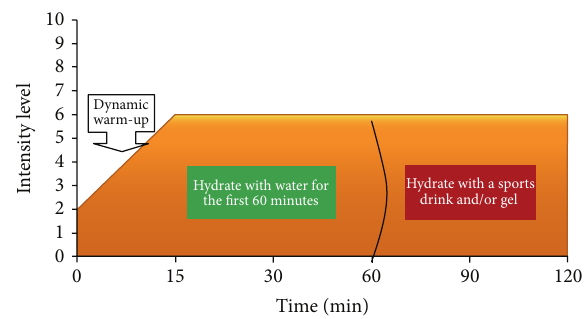
Figure 2: Endurance exercise (E). Perform endurance (E) exercise at an intensity level of 6 for 60 minutes or longer using any form of exercise (walking, jogging, running, cycling, swimming, hiking, cross-country skiing, snowshoeing, rollerblading, rowing, etc.). Ideally, perform E outside in nature and in the morning. At the beginning and end of each E session perform a 5-minute dynamic warm-up and a cool-down gentle stretch, respectively.